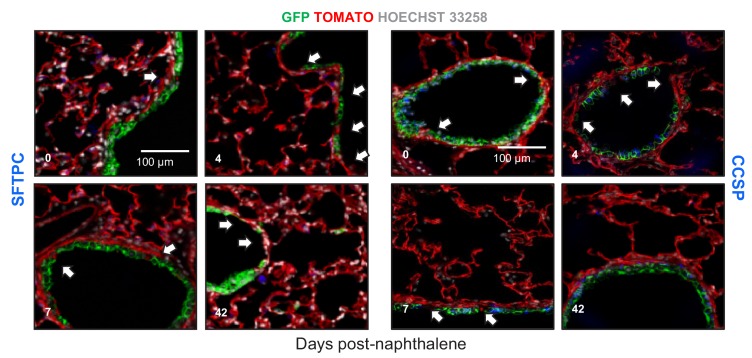
Airway epithelial cell ablation using naphthalene is restored by airway-labeled cells: representative images.Representative fluorescent microscopic images of lungs of GFP;CCSP.CRE mice at different time-points after intraperitoneal injection of 250 mg/Kg naphthalene given at six weeks of age. Shown are merges of Hoechst 33258-stain, endogenous TOMATO- and GFP-labeling, and immunostains for surfactant protein C (SFTPC, left) or Clara cell secretory protein (CCSP, right). Arrows denote naphthalene-induced airway epithelial gaps that are restored by GFP-labeled airway cells that express CCSP, but not SFTPC protein.